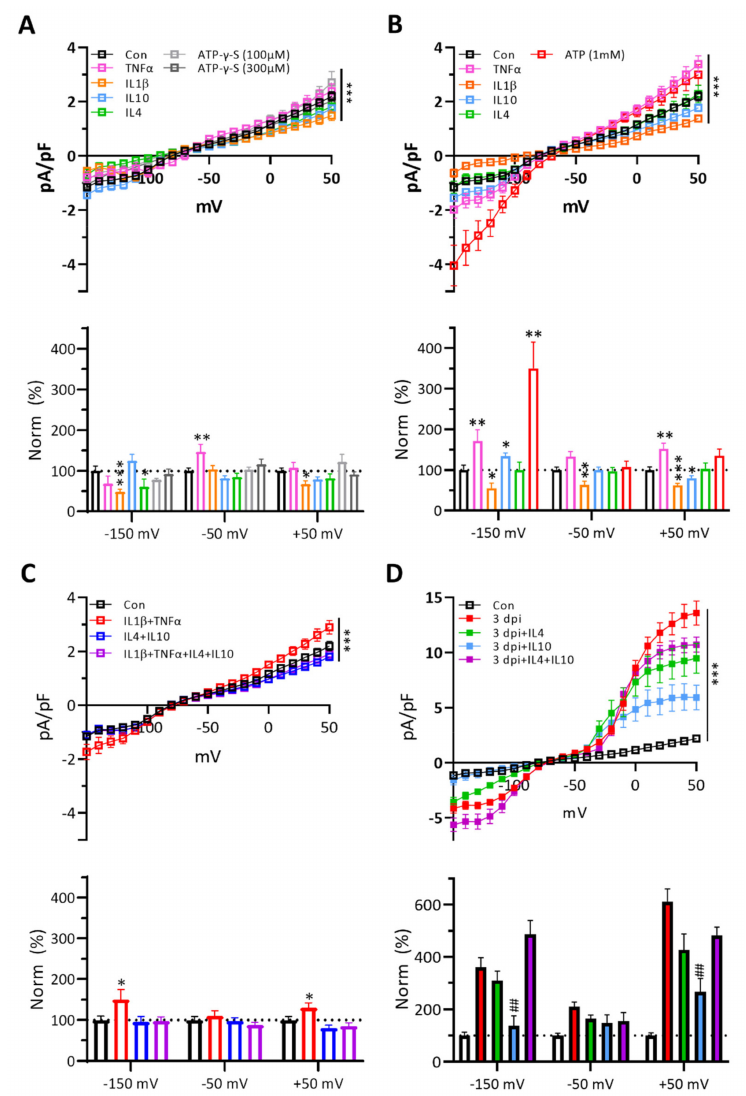
Figure 6. Effect of each cytokine and ATP on the membrane current density of GFP (+) naïve and 3 dpi microglia in response to a voltage-ramp. The current density was averaged by 10 mV increment. Two-way ANOVA with Tukey’s test or two-tailed t -test for comparing the experimental group (*) or to the 3 dpi group (#) (*, # for p < 0.05; **, ## for p < 0.01; ***, ### for p < 0.001). Two-way ANOVA and Tukey’s test, *** p < 0.001. ( A ). Top : Effects of each cytokine at a low-concentration (10 ng/mL) and ATP- γ -S (100 and 300 µ M) on the voltage-activated current density of GFP (+) naïve microglial cells. Two-way ANOVA with Tukey’s test. Bottom : Normalized current densities at − 150, − 50 and +50 mV. Two-tailed t -test. ( B ). Top : Effects of each cytokine at a high-concentration (30 ng/mL) and ATP (1 mM) on the voltage-activated current density of GFP (+) naïve microglial cells. Two-way ANOVA with Tukey’s test. Bottom : Normalized current densities at − 150, − 50 and +50 mV. Two-tailed t -test. ( C ). Top : Combined effects of two or four cytokines (each 10 ng/mL) on the voltage-activated current density of GFP (+) naïve microglial cells. Two-way ANOVA with Tukey’s test. Bottom : Normalized current densities at − 150, − 50 and +50 mV. Two-tailed t -test. ( D ). Top : Effects of IL-4, IL-10 or both, at low-concentrations (10 ng/mL) on the voltage-activated current density of GFP (+) 3 dpi microglial cells. Two-way ANOVA with Tukey’s test. Bottom : Normalized current densities at − 150, − 50 and +50 mV. Two-tailed t